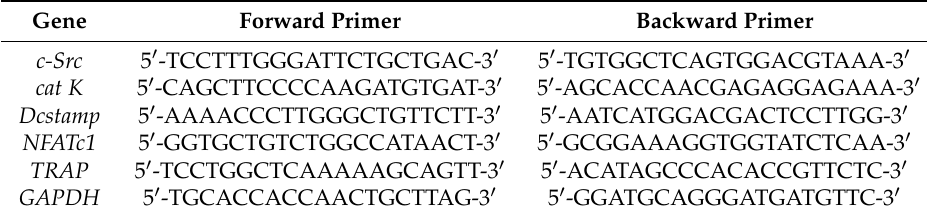
Table 2. Real-time PCR primers for